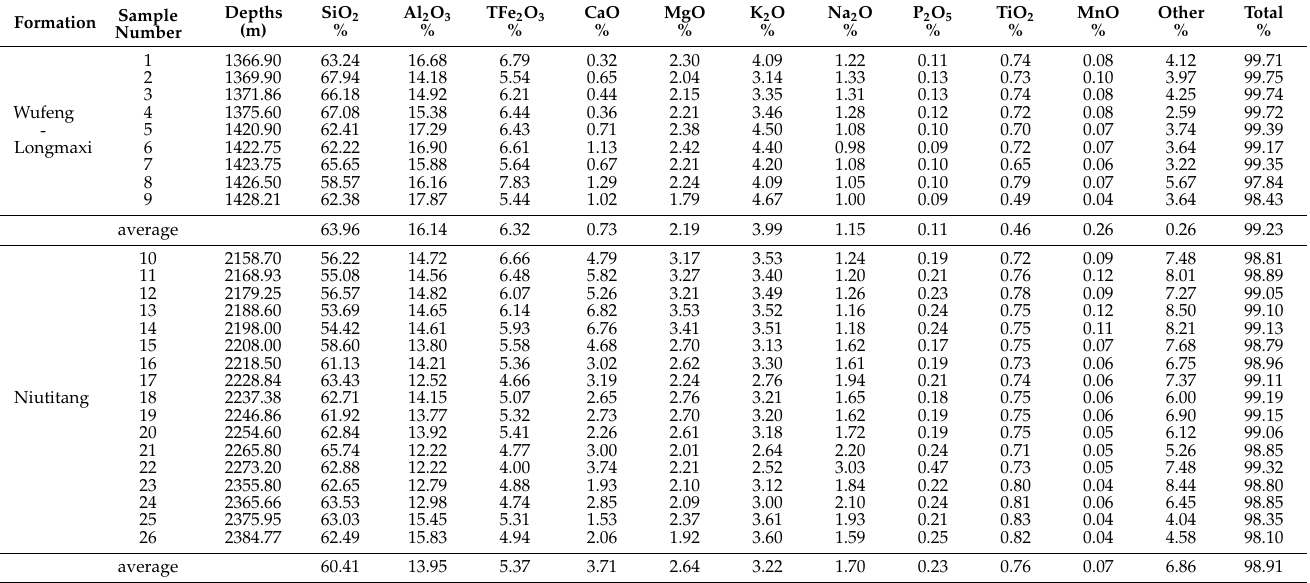
Table 2. Major elements data of Wufeng-Longmaxi and Niutitang